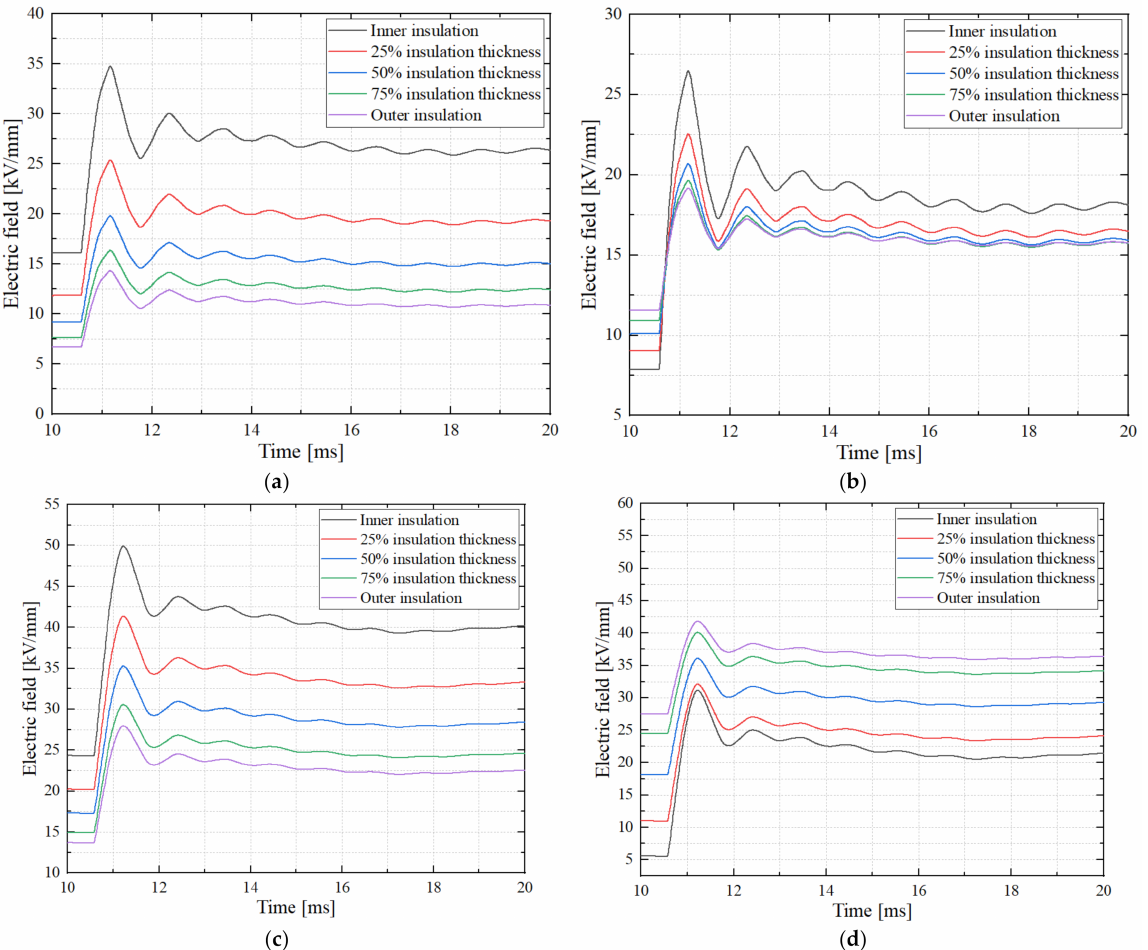
Figure 10. Electric field distribution in cable insulation under transient overvoltage conditions ( a ) XLPE cold cable; ( b ) XLPE hot cable; ( c ) PP cold cable; ( d ) PP hot